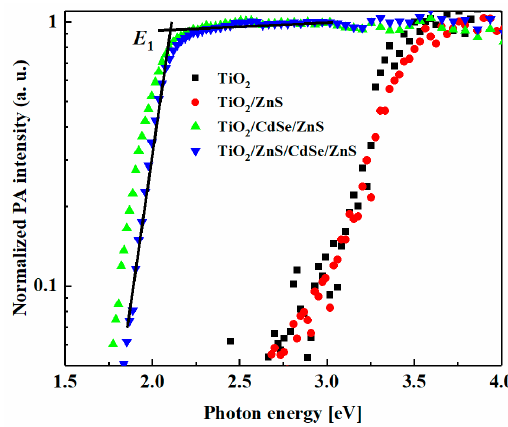
Figure 2. Normalized photoacoustic (PA) spectra of TiO 2 , TiO 2 /ZnS, TiO 2 /CdSe QD/ZnS and TiO 2 /ZnS/CdSe QD/ZnS. TiO 2 /ZnS/CdSe